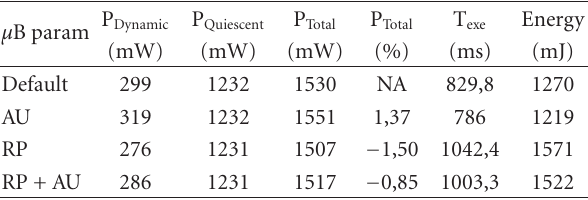
Table 11: Impact of the MicroBlaze configurations for the DIALIGN algorithm at 100MHz for